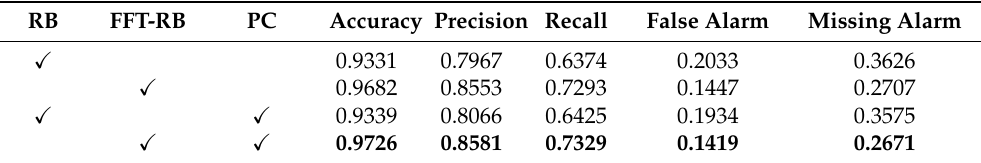
Table 4. Evaluation of Ablation